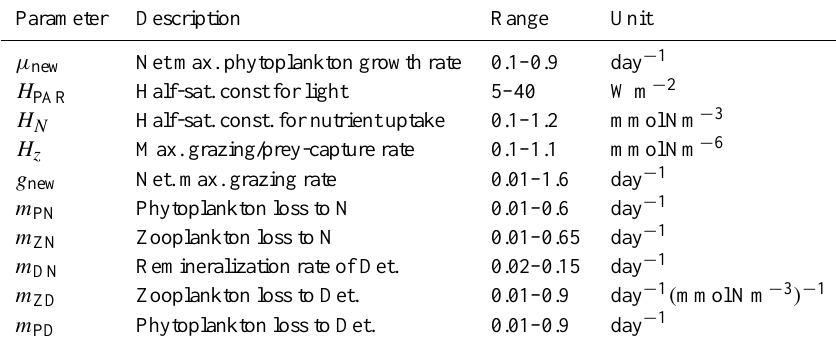
Table 1. Model parameters and associated ranges explored in this study.